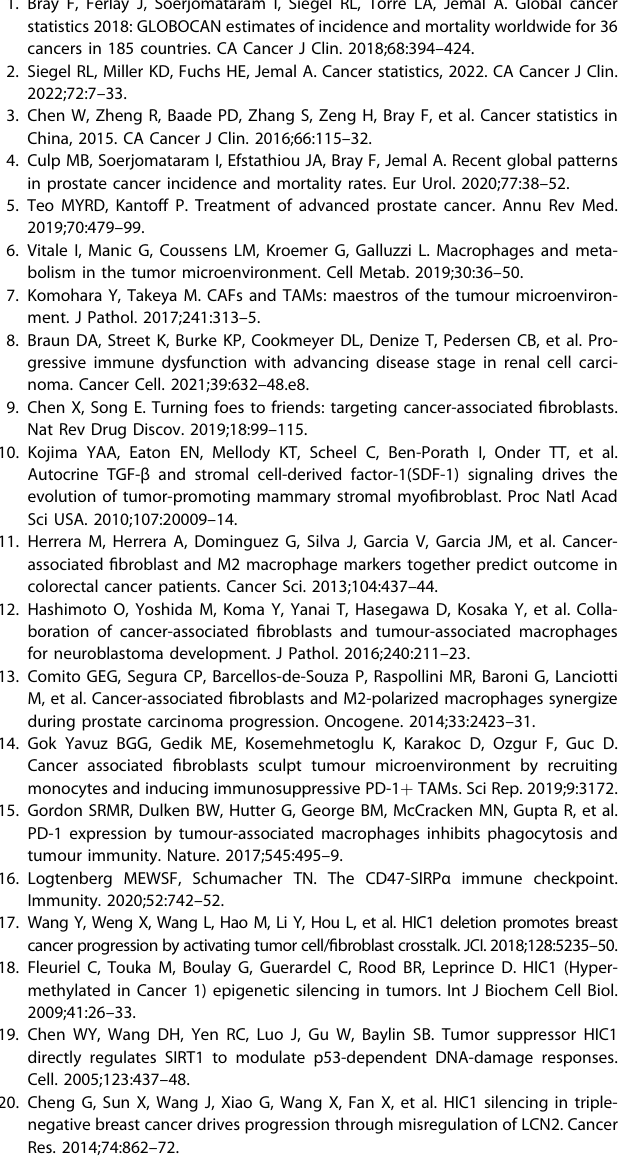
Fig. 7 The HIC1-TGFB1-CXCL5 loop is associated with disease progression in patients with PCa. a Representative IHC images of TMA showing the corresponding expression of stromal CD206 and CXCL5 in PCa tumor tissues. Scale bar: 200 (upper panel) and 50 μ m (lower panel). b Analysis of a number of CD206 staining cells in stroma between normal and tumor, stage I – II and stage III – IV tissues. c Analysis of CXCL5 staining in stroma between normal and tumor, stage I – II and stage III – IV tissues ( P values were obtained using two-tailed Student ’ s t tests. The Whiskers connect the minimum and the maximum values to the Box; * P < 0.05, ** P < 0.01, *** P < 0.001; **** P < 0.0001). d The correlation between CD206 + cells and CXCL5 expression levels in stroma. Spearman r = 0.541. The correlation was calculated by Spearman correlation analysis. e IHC staining of stromal CD206 in primary tumor and metastatic lymph nodes from the same patient. Black arrows represent M2 macrophages. Lower panel: quantitative analysis of in fi ltrating macrophages in primary tumor compared with in fi ltrating macrophages in metastatic LNs. P values were obtained using two-way ANOVA. Scale bar: 200 (upper panel) and 50 μ m (lower panel). f Schematic model shows how HIC1-mediated crosstalk between cancer cells, macrophages, and fi broblasts promotes in the process of PCa progression. Conditional deletion of Hic1 and Pten in mouse prostate epithelium contributes to the malignant phenotype of PCa. HIC1- induced higher TGF- β secretion in TME promotes M2 macrophage activation and up-regulates CXCR4 expression by inducing c-Myc